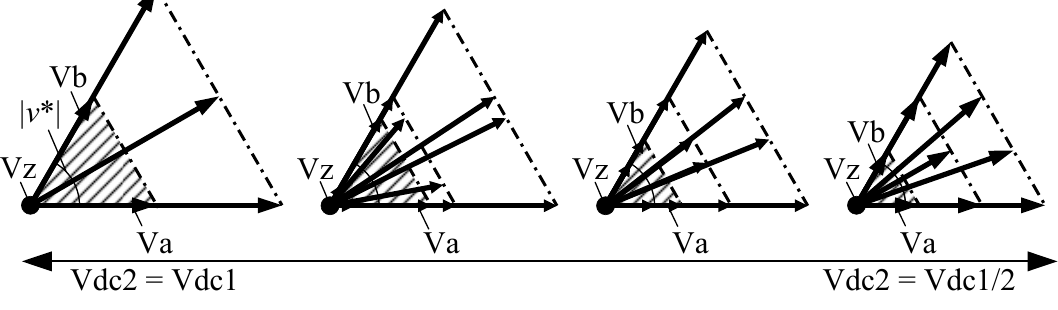
Figure 7. Switching over technique for fault tolerant operation in case of 0 < m ≤ 0.25.